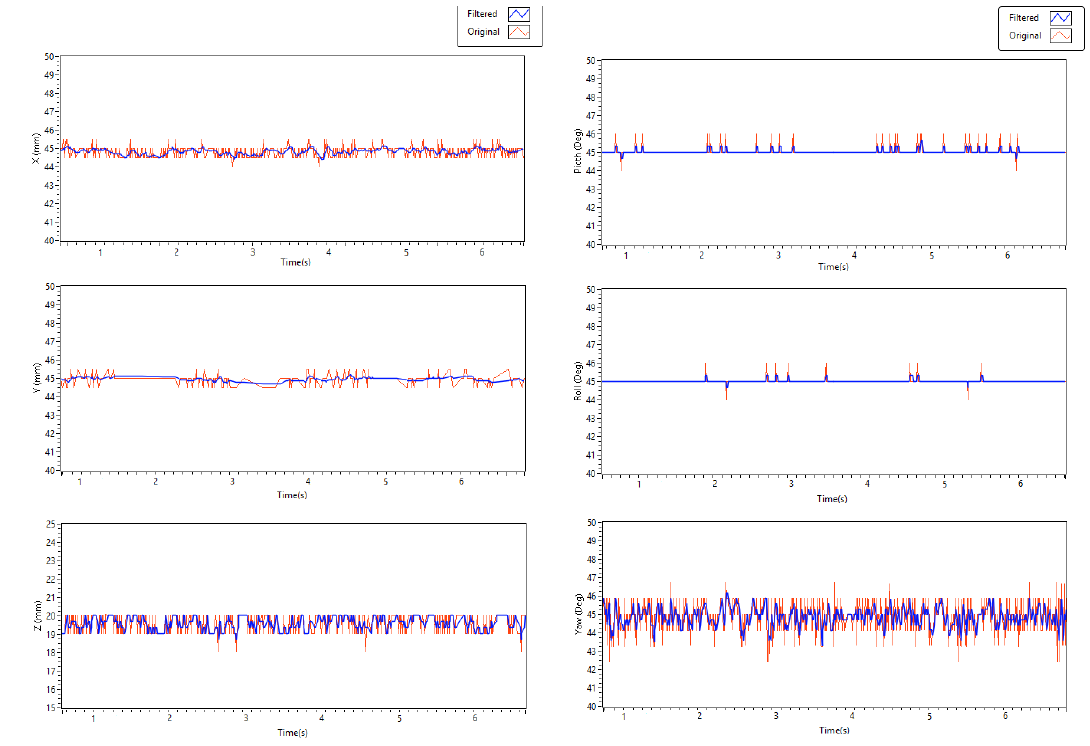
Figure 6. Static position and orientation accuracy test